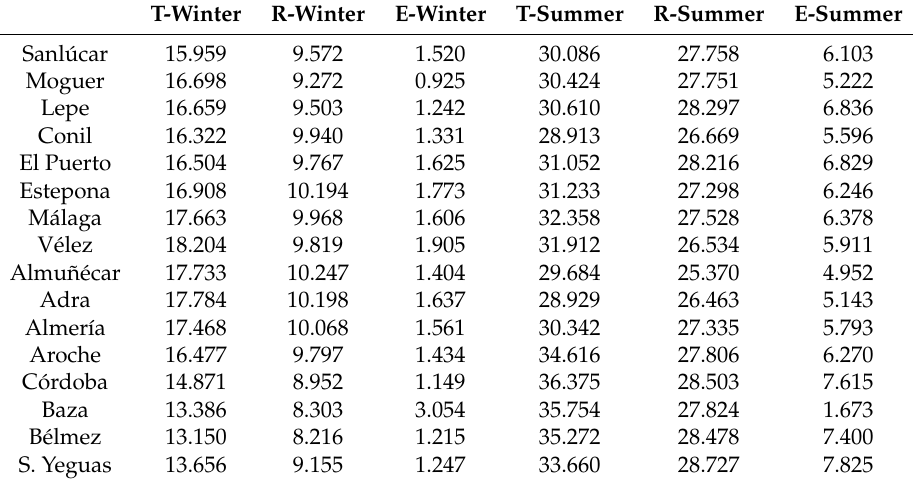
Table A1. Mean values of high temperature (T) in Celsius Degrees, radiation (R) in MJ / m 2 , and evapotranspiration (E) in mm/day, measures in January (winter time) and July (summer time) between 2013 and